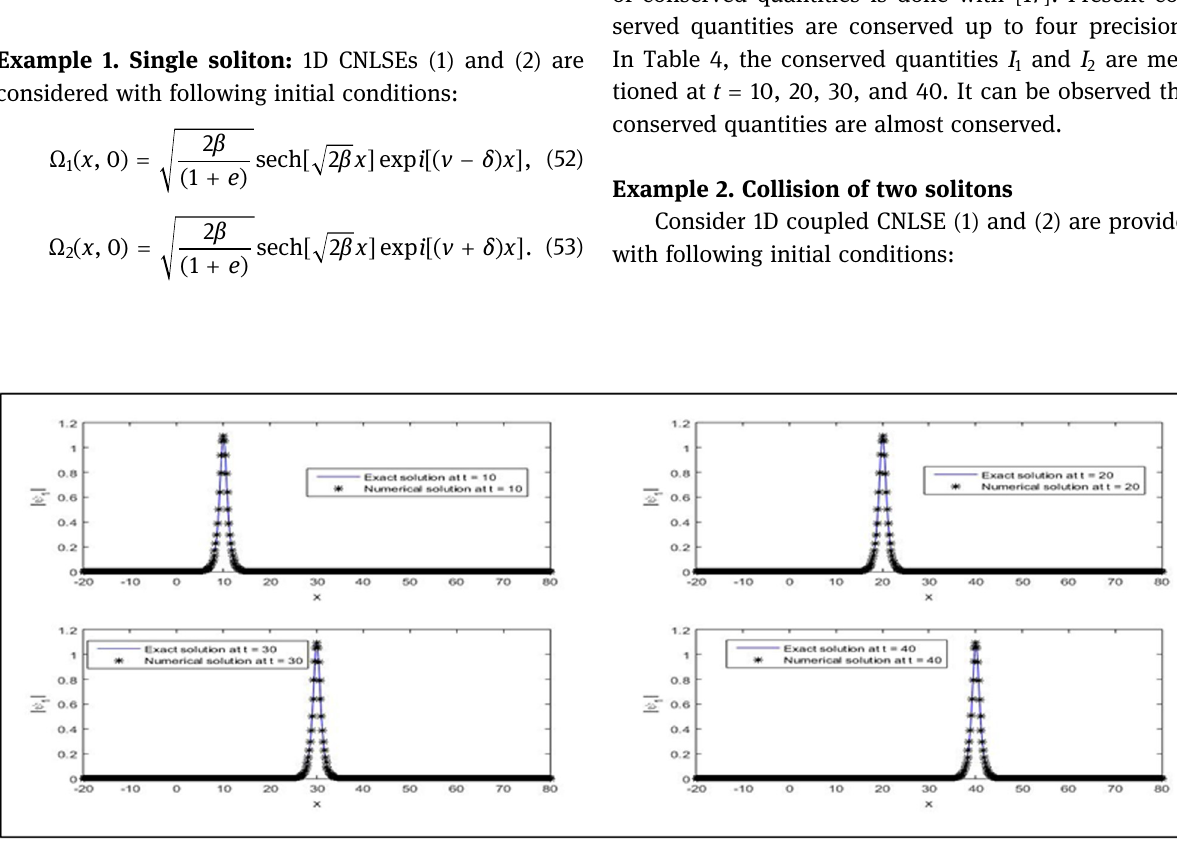
Figure 1: Solutions of fi rst - wave amplitude for and